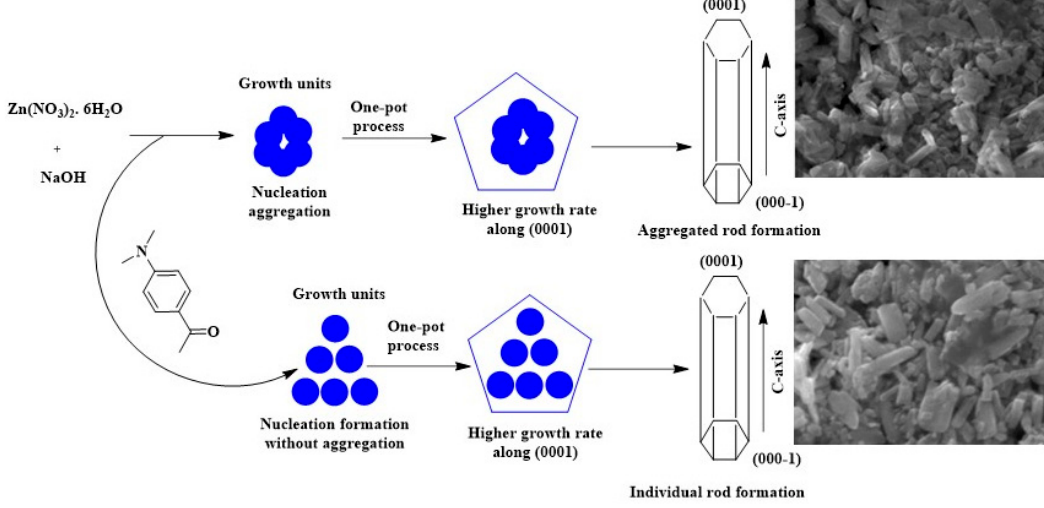
Figure 1. Growth mechanism of ZnO NPs by different approaches.